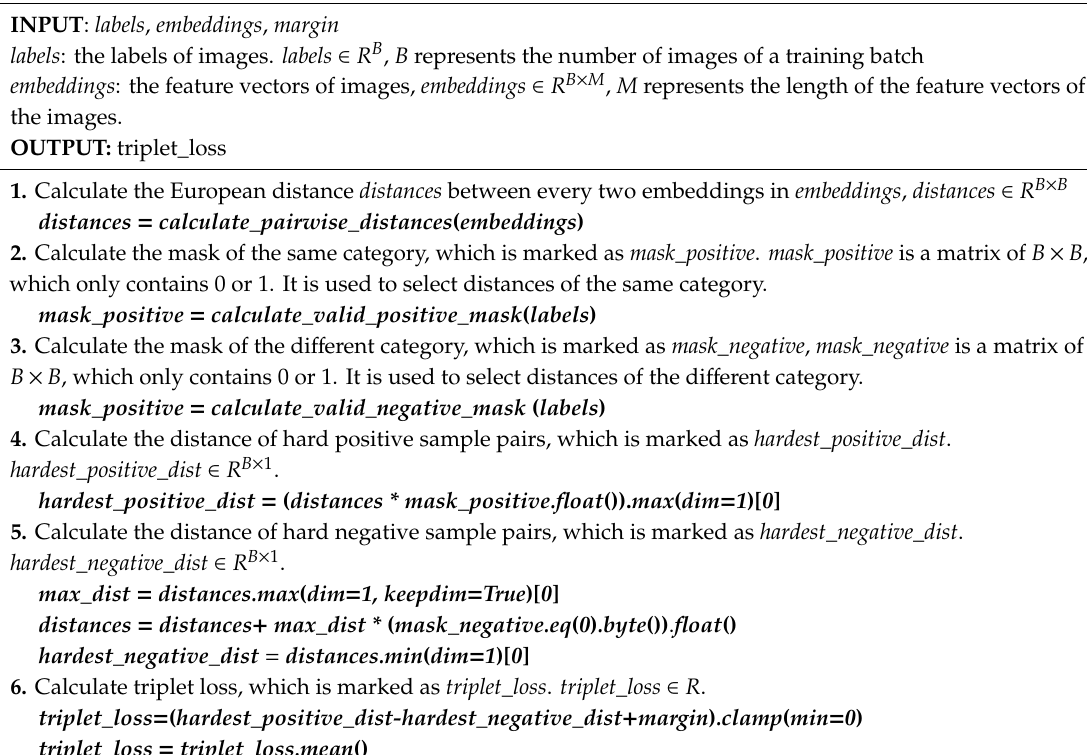
Algorithm 1 Batch hard triplet